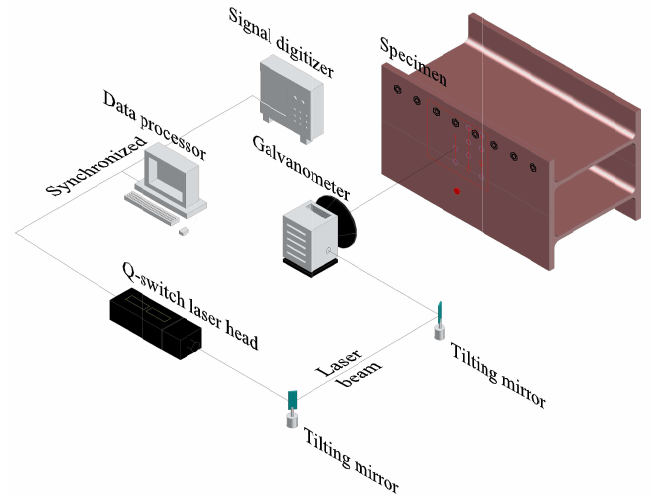
Figure 3. Conceptual diagram of an ultrasonic wave propagation imaging